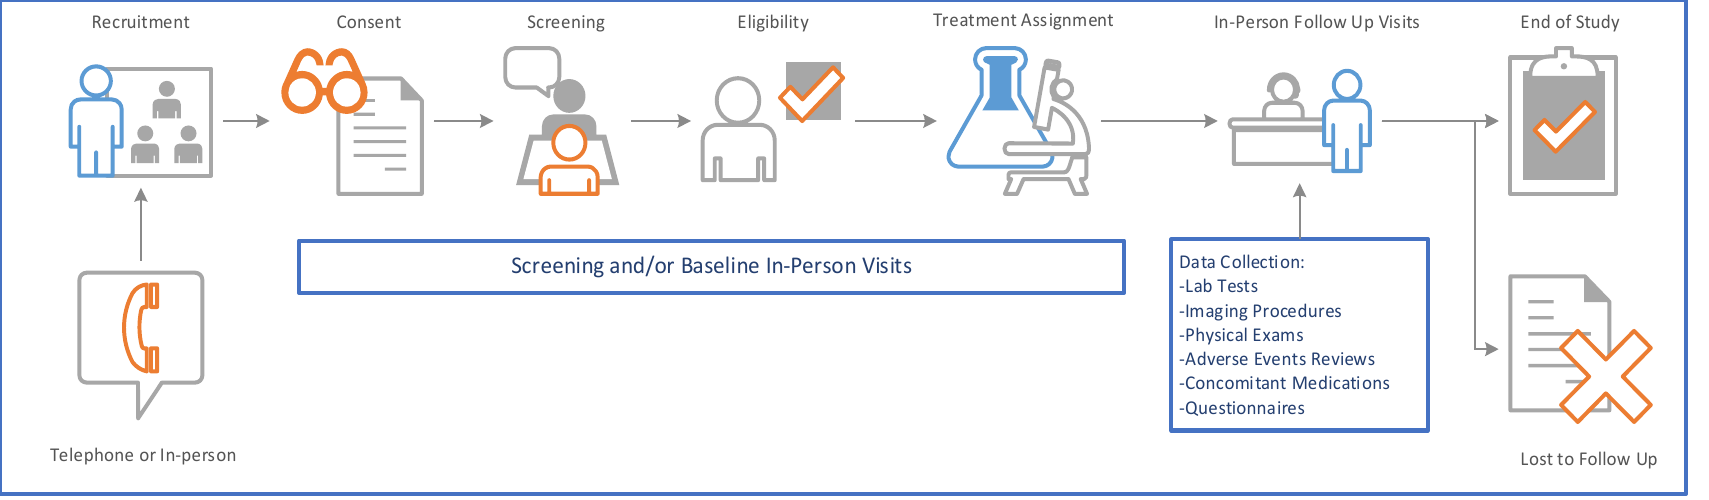
Figure 1. Traditional model of randomized controlled trials with data collected at in-person study visits.